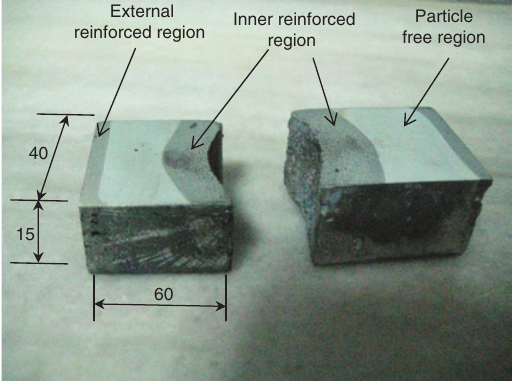
Figure 3 Macroscopic photograph showing two FG SiC-reinforced composite materials.